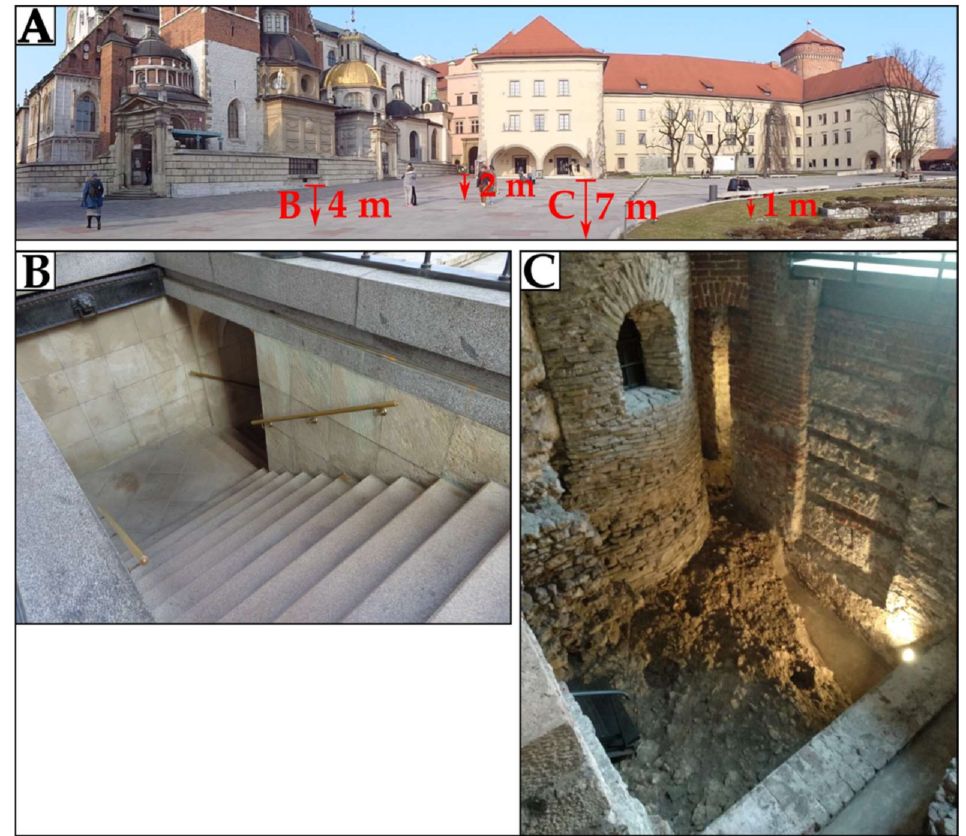
Figure 14. Differentiated thickness of cultural deposits within the plateau of the Wawell Hill, which caused surface flattening. ( A )—eastern part of the plateau, the Cathedral and the part of the Royal Castle. Location of the selected objects and thickness of cultural deposits in their surrounding: ( B )—stairs leading to the initial level “0” of the Cathedral; ( C )—part of the Underground